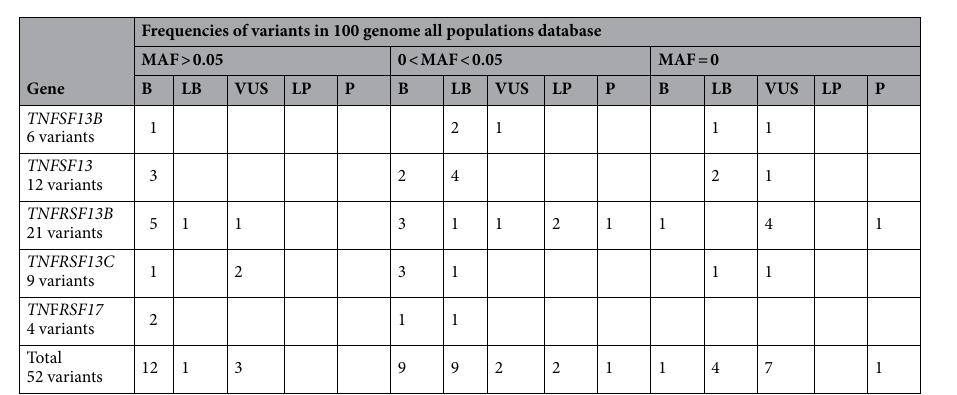
Figure 2. Median of the relative expression of non-functional isoforms of BAFF and APRIL. ( a ) Median of the relative expression εAPRIL/α+γ− in patients and controls. ( b ) Median of the relative expression βAPRIL/α+γ in patients with and without nephritis. ( c ) Median of the relative expression ΔBAFF/functional isoforms in patients with and without dsDNA antibodies.